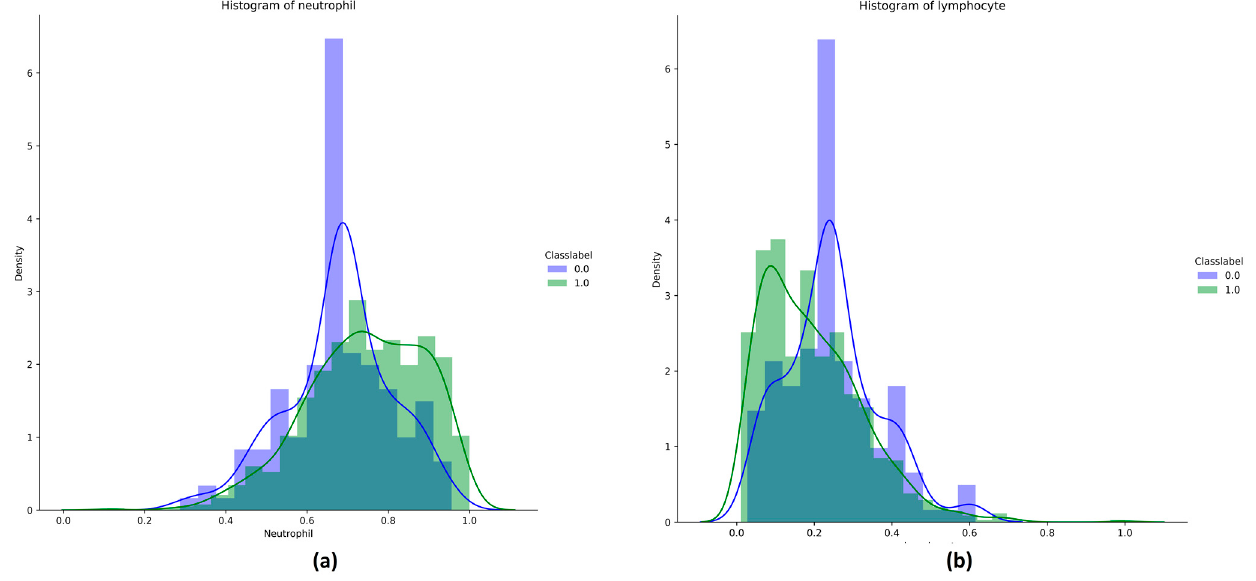
Figure 2. Histograms of neutrophil and lymphocyte counts for COVID-19 and non-COVID-19 patients. (0—non-COVID-19 ILI patients, 1—COVID-19 patients). ( a ) Neutrophil ( b ) Lymphocyte. Gender was the only categorical variable present in the dataset. The dataset had 665 male patients and 504 female patients. The COVID-19 negative ILI class had 114 male patients and 156 female patients. The COVID-19 class had 551 male patients and 348 female patients. The gender count for each class is pictorially depicted using a bar graph in Figure 3.